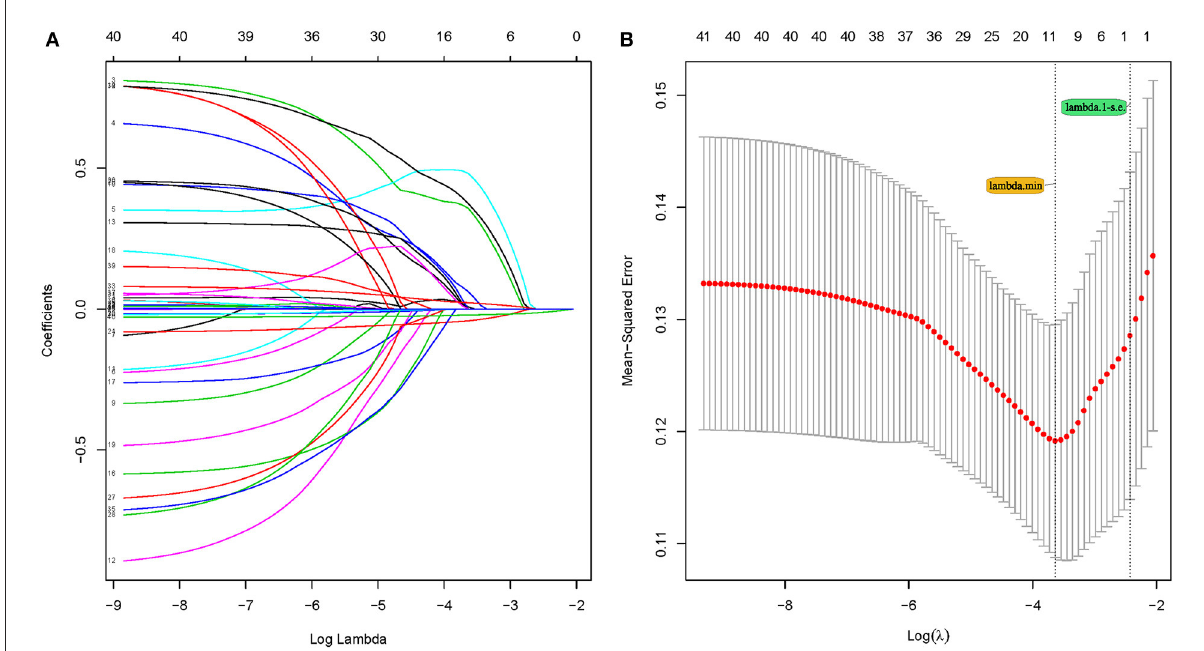
FIGURE2 Feature selection using the least absolute shrinkage and selection operator (LASSO) Cox regression model. (A) LASSO coefficient profiles of the 41 features. (A) coefficient profile plot was produced against the log ( λ ) sequence. (B) Selection of tuning parameter ( λ ) in the LASSO regression using 10-fold cross-validation via minimum criteria. At the optimal values log ( λ ), where features are selected, two dotted vertical lines were drawn at the optimal scores by minimum criteria and 1-s.e. criteria.